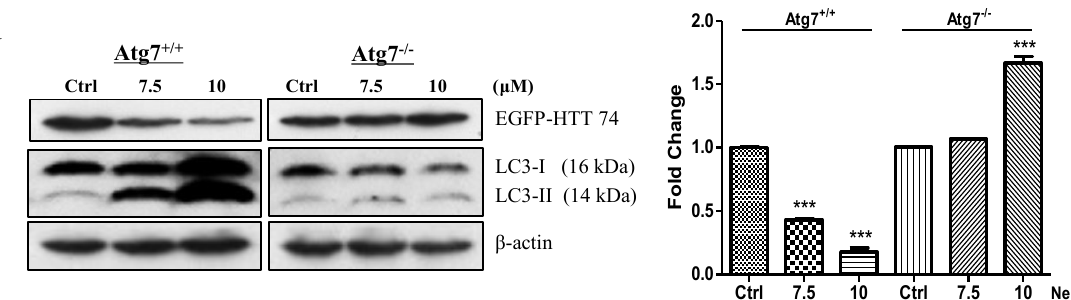
Figure 3. Neferine enhances the clearance of mutant huntingtin. ( A ) PC-12 cells transfected with EGFP- HTT 74 for 16 h were treated for 24 h with neferine at 7.5 µM and 10 µM, respectively. The protein level of mutant huntingtin decreased with an increased level of LC3-II after neferine treatments. EGFP-HTT 74 band intensities were quantified and normalized to β-actin. ( B ) PC-12 cells transfected with EGFP- HTT 74 were analyzed by real-time PCR on the huntingtin level after 24 h of neferine (7.5 µM) treatment. No significant change in the transcriptional level of huntingtin was observed after neferine treatment. ( C ) Wild-type Atg7 and Atg7-deficient mouse embryonic fibroblasts (MEFs) transfected with GFP-LC3 for 16 h were treated with neferine (7.5 µM) for 24 h. Representative images demonstrated that the number of LC3-positive cells was low in Atg7-deficient MEFs when compared with wild-type MEFs. ( D ) Bar chart indicating the percentage of cells with GFP-LC3 puncta formation after treatments. ( E ) Wild-type Atg7 and Atg7-deficient MEF cells transfected with EGFP- HTT 74 were treated with neferine (7.5 µM) for 24 h before being subjected to fluorescent microscopy analysis. Representative images revealed that the number of EGFP-HTT 74 inclusions was larger in Atg7-deficient MEFs when compared with wild-type MEFs. ( F ) Bar chart showing the percentage of cells with EGFP-HTT 74 inclusion formation. ( G ) Wild-type Atg7 and Atg7-deficient MEF cells transfected with EGFP- HTT 74 for 16 h were treated with 24 h of neferine (7.5 and 10 µM). The protein level of mutant huntingtin was reduced with an increased level of LC3-II in wild-type, but not Atg7-deficient MEFs. EGFP-HTT 74 band intensities were quantified and normalized to β-actin. Data are expressed as the fold change relative to the DMSO-treated, negative control. Bars: S.D. *** p < 0.001. Magnification: ×40. Scale bar: 15 µm. Columns are the means of three independent experiments. Ctrl,